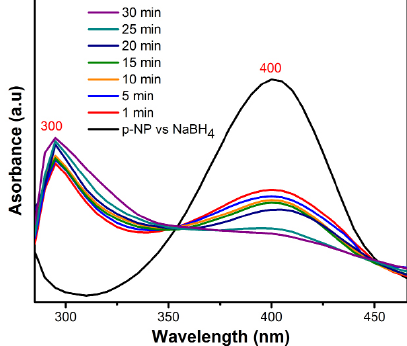
Fig. 7. UV-vis spectra of p -nitrophenol reduction with various reaction times using Cu O NCBs/CS NPs composites 2 as a photocatalyst material.